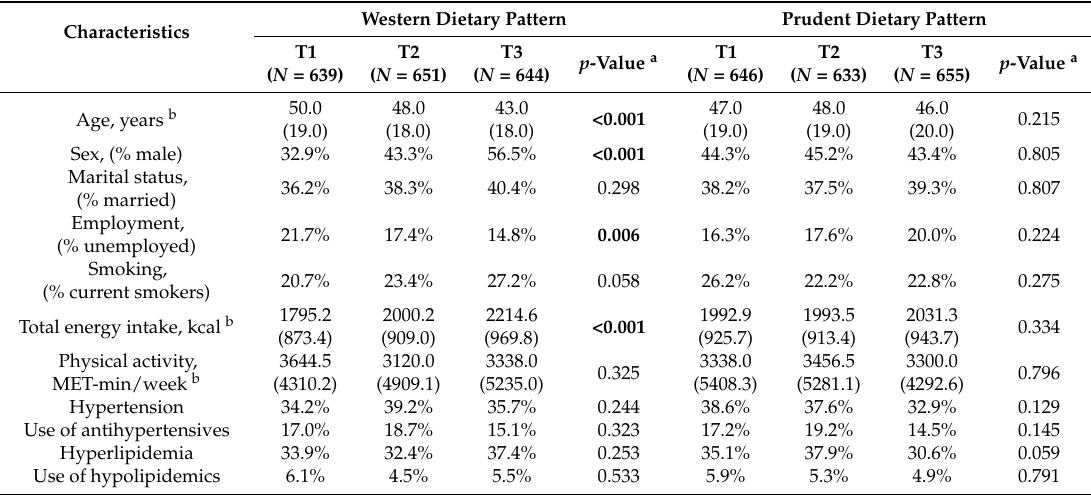
Figure 3. Radar graph of factor loadings characterizing each dietary pattern. Red line indicates factor loadings related to the western dietary pattern. Green line indicates the factor loadings related to the prudent dietary pattern. Table 2. Characteristics of study participants by tertiles of dietary patterns.